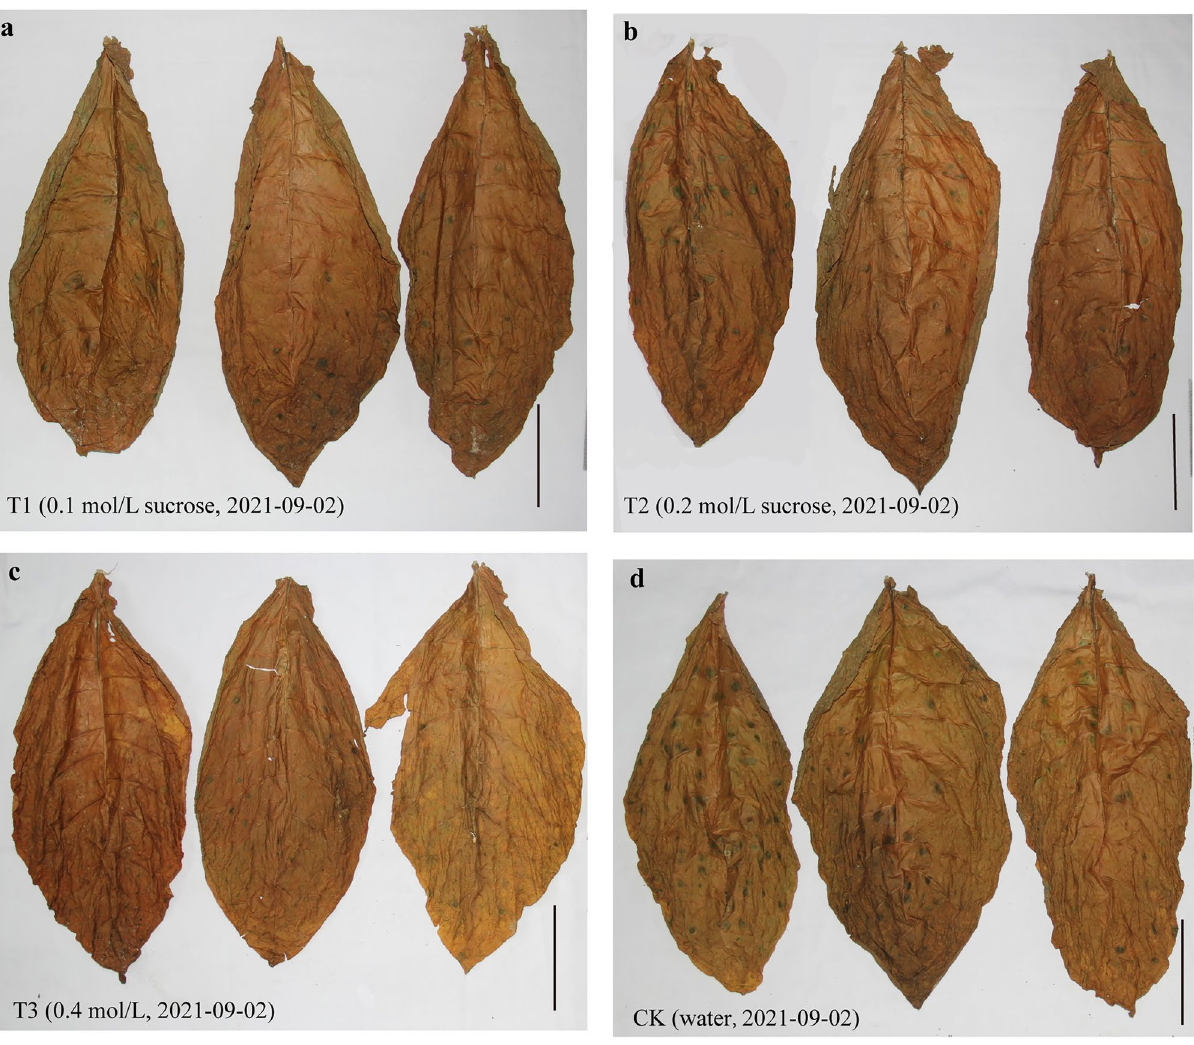
Figure 2. The appearance of tobacco leaves under different treatments at the end of air-curing. ( a – d ) for the T1, T2, T3 and CK treatments; bar = 15